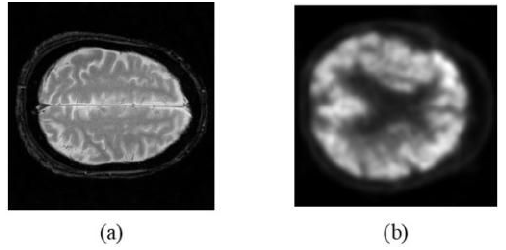
Figure 2. ( a ) T2-weighted MR (Magnetic Resonance) image of AD. ( b ) PET (Positron Emission Tomography) image of